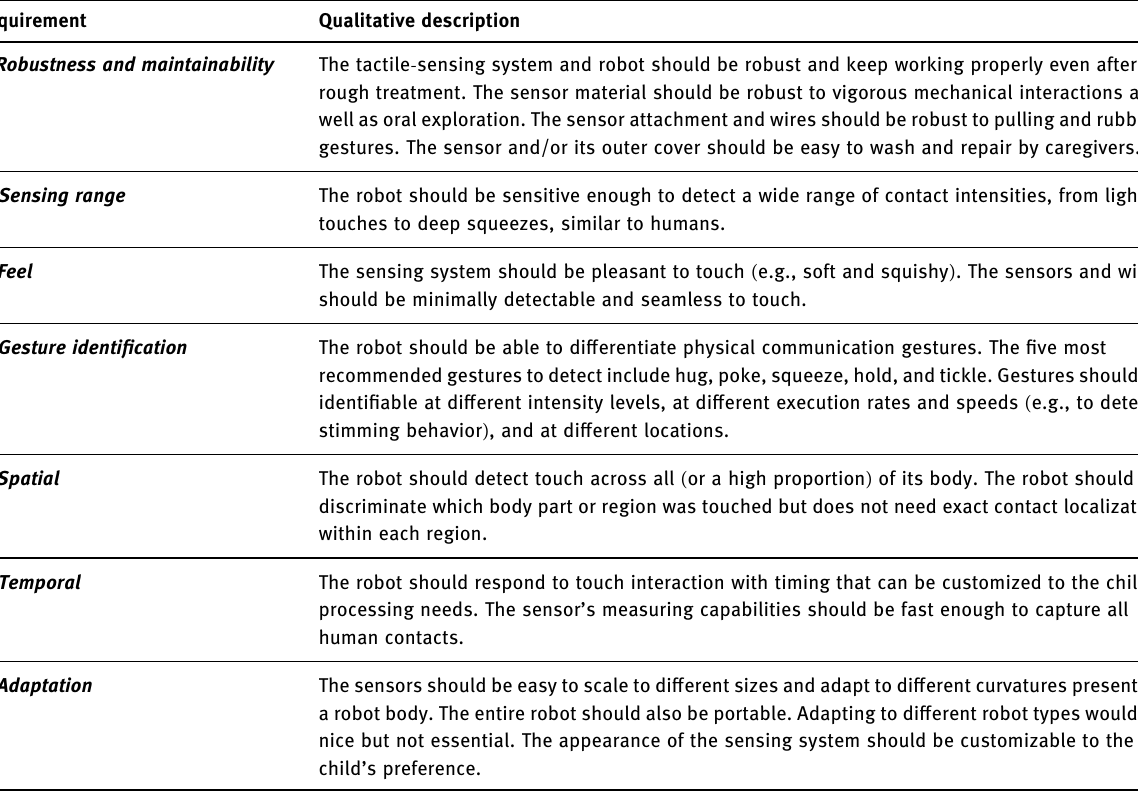
Table 3: Our fi nal qualitative guidelines for a touch - sensing robot companion for children with autism, as derived from the recommen - dations of 11 autism specialists. Requirements are listed in descending order of importance, with 1 indicating most